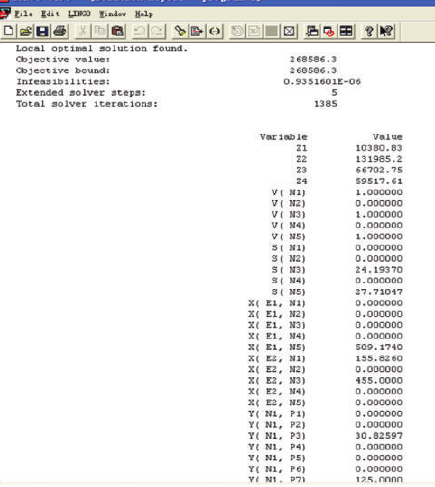
Figure 1: Results of the low-carbon model.